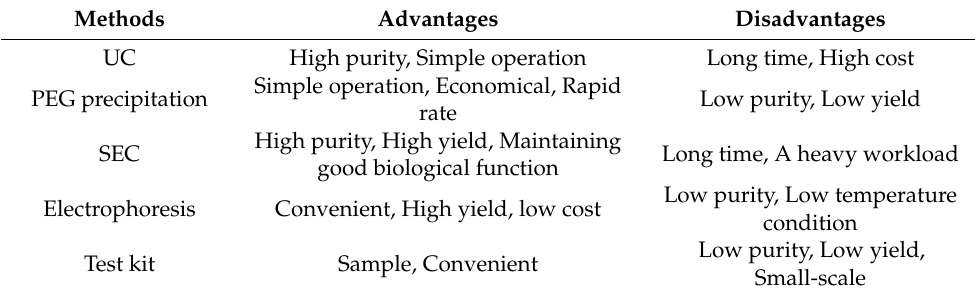
Table 2. Extraction of Plant derived EVs and Their Advantages and Disadvantages.